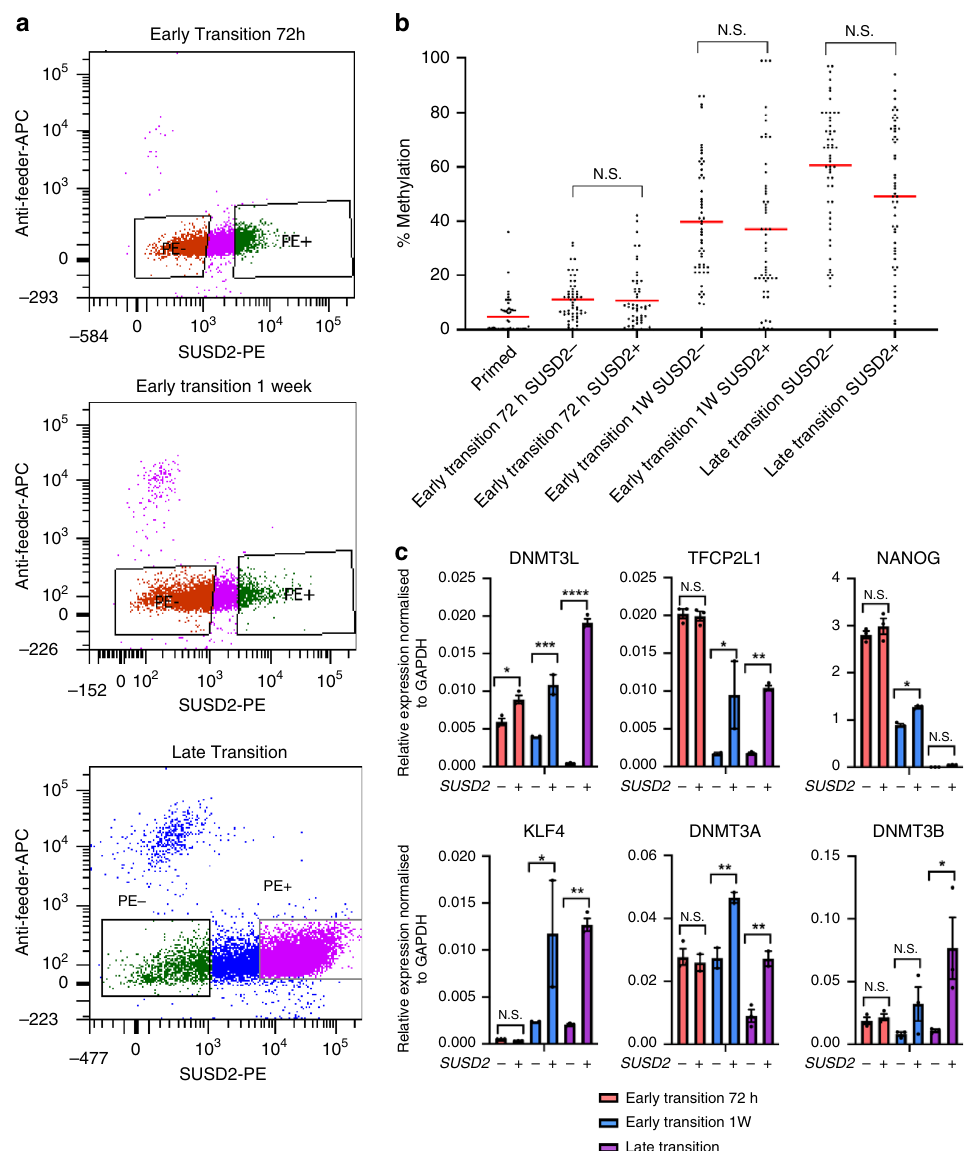
Fig. 4 Hypermethylation is a feature of resetting and is not restricted to emerging naïve cells. a Flow cytometry dot plots showing SUSD2-PE staining on the x-axis against anti-feeder-APC staining on the y-axis for hESCs during the early and late transition. Boxes indicate SUSD2 + and SUSD2- cell populations that were sorted. b Plot showing the % methylation in primed, early transition and late transition hESCs, for SUSD2 + and SUSD2 − cell populations. Each dot represents the methylation % of single CpGs ( n = 57) from four genomic regions analysed by targeted bisul fi te sequencing, and the red bars represent the mean methylation level for each sample. Statistical difference between samples was analysed by a Kruskal – Wallis test, with Dunn ’ s multiple comparisons post hoc test. N.S. denotes not signi fi cant ( p > 0.05). c qRT-PCR for naïve pluripotency genes in SUSD2 + and SUSD2 − cell populations early and late transition hESCs. Bars represent the mean of three technical replicates and error bars represent SEM. Statistical signi fi cance between samples was analysed with a one-way ANOVA with a Bonferroni post hoc test comparing all samples to each other. Human GAPDH was used to normalise expression. * P < 0.05, ** P < 0.01, *** P < 0.001, **** P < 0.0001, N.S. denotes not signi fi cant. Source data are provided as a Source Data fi